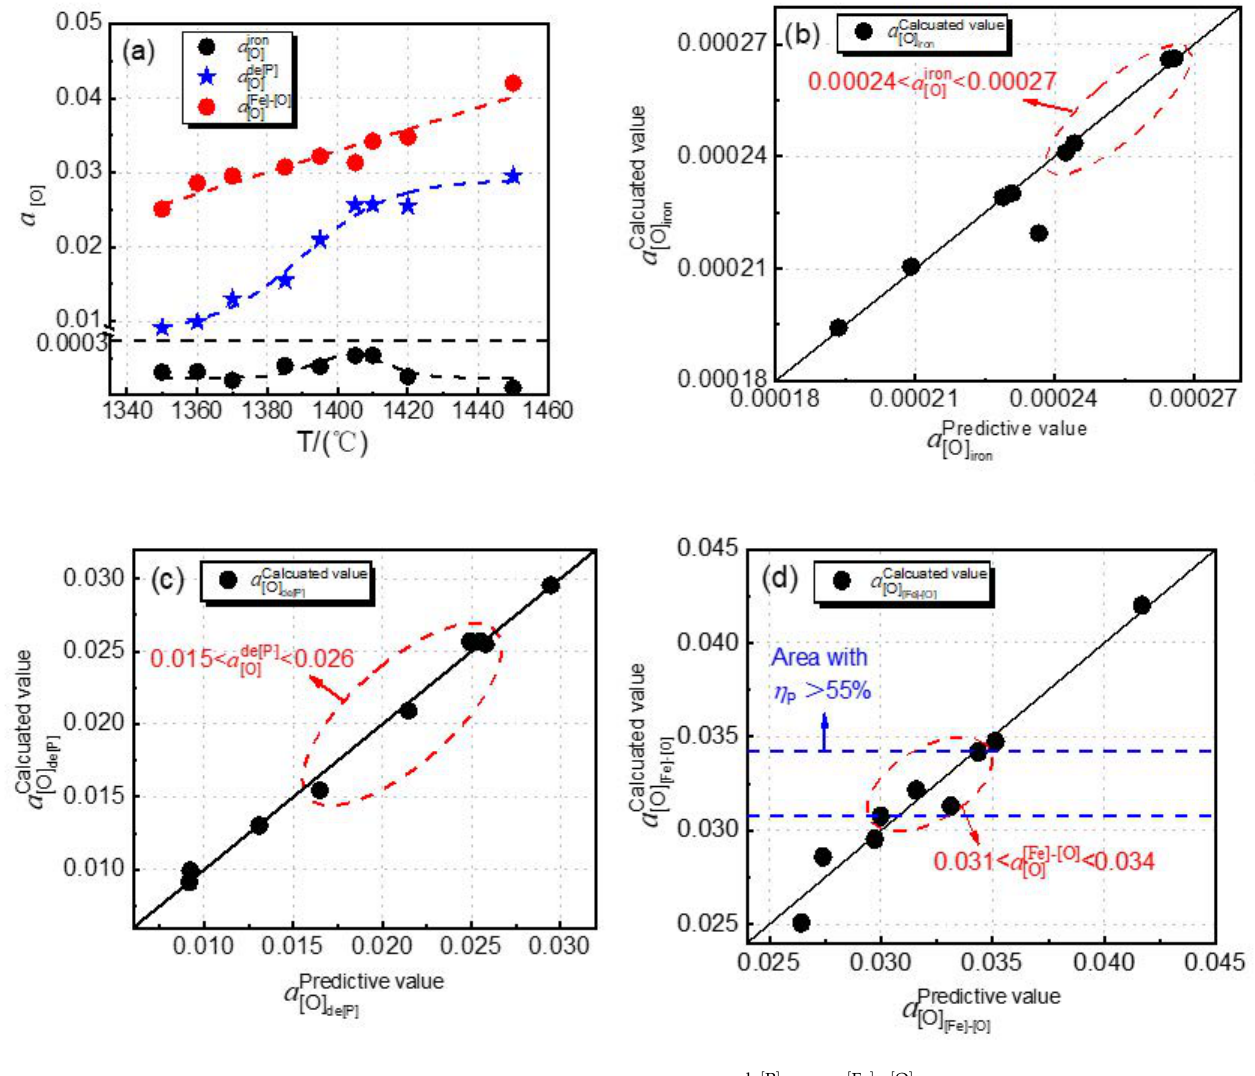
Figure 9. ( a ) Effect of dephosphorization endpoint temperature on a iron value and calculated value based on multiple regression, ( b ) a iron